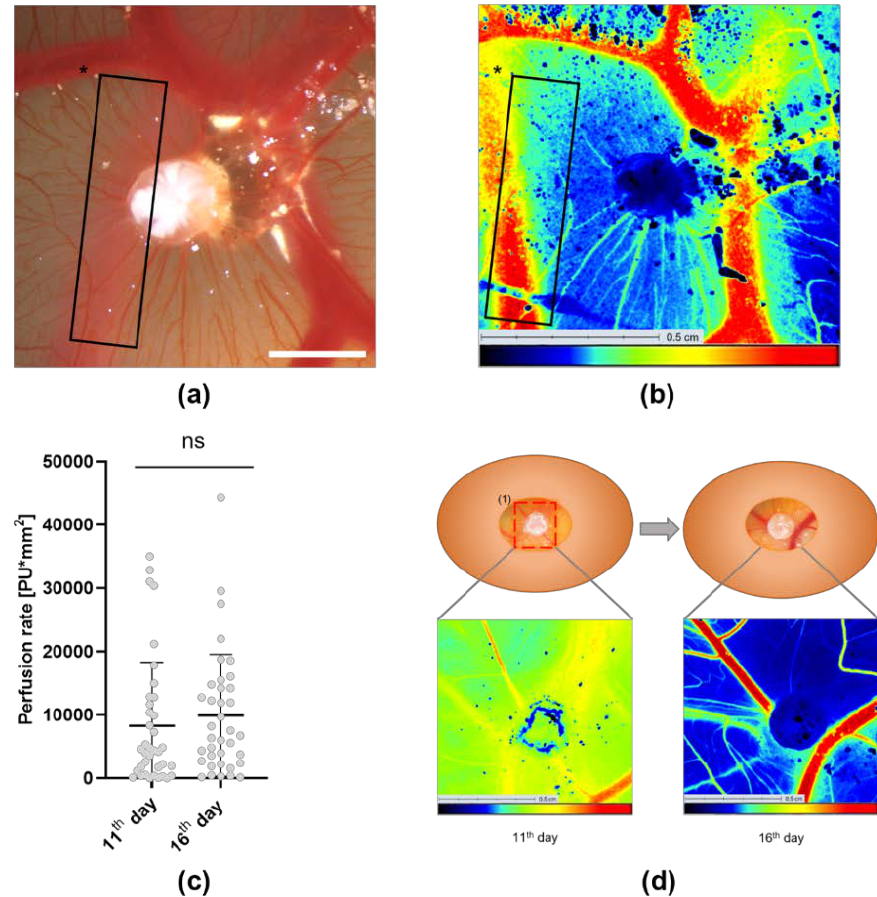
Figure 4. Analysis and illustration of the LSCI-based angiogenesis measurements of CAMs grafted with AS-M cell line tumors (the white bar indicates 2 mm). ( a ) The vessel marked with a * in the microscopic image is blurry because of its location underneath the surface of the CAM but is ( b ) partially recognized by LSCI. ( c ) Scatterplot diagram showcasing the mean blood flow of the CAM calculated by multiplying the perfusion rate (PU) and the perfused area (mm 2 ) shows an increase from the 11th to 16th day of incubation after applying a perfusion filter of 800–3000 (PU) to the LSCI measurements. The data was evaluated using one-way ANOVA with Tukey ´ s multiple comparisons tests (n = 36). The significance level was set at p < 0.05. ( d ) Illustration of the measurement protocol for the LSCI measurements of the CAM